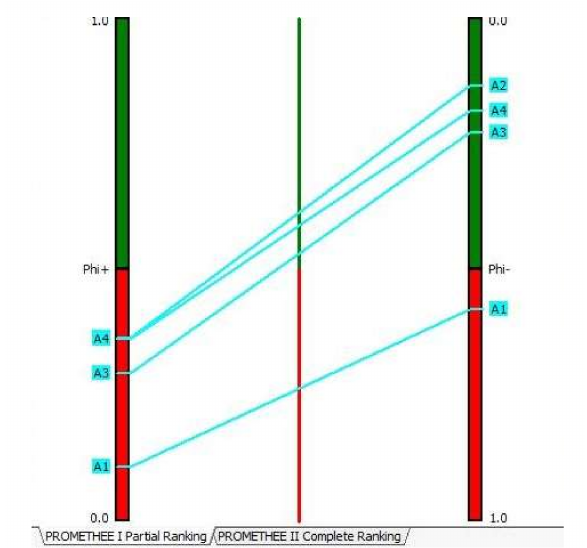
Figure 13. Partial ranking of alternatives based on the PROMETHEE I method, taking into consideration all categories of possible decisions (Mikro Derio